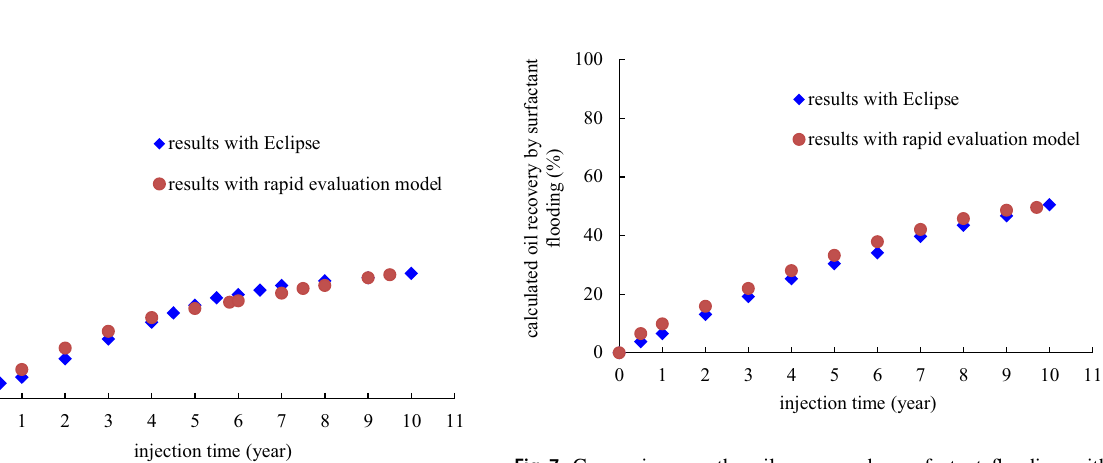
Fig. 4 Numerical simulation result by gas flooding (2 year) from Eclipse with the basic parameters